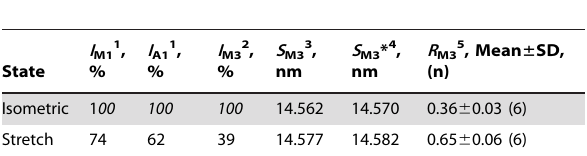
Table 1. Changes in the intensity and spacing of some x-ray reflections upon